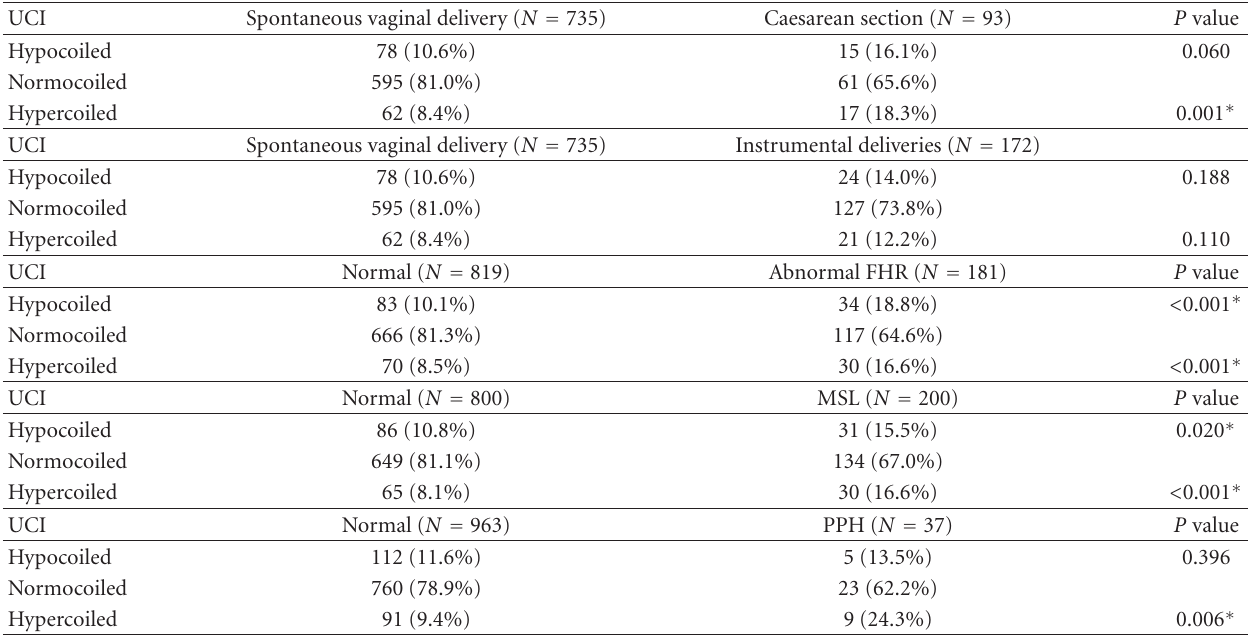
Table 4: Distribution frequencies of the three groups according to the intrapartum